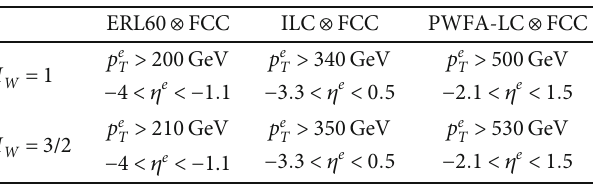
Table 2: Discovery